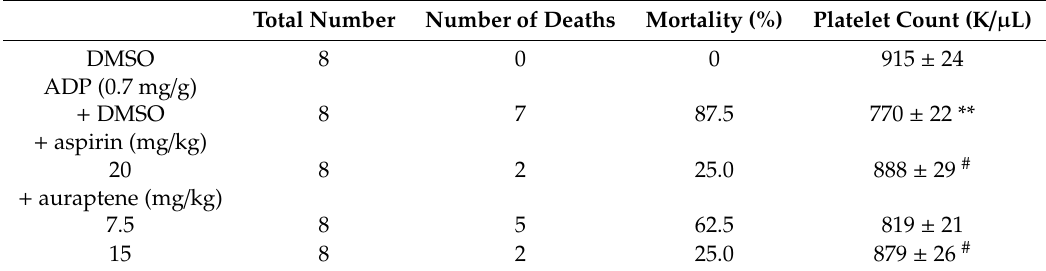
Table 1. E ff ect of aspirin and auraptene on mortality and platelet count of acute pulmonary thrombosis caused by intravenous injection of adenosine diphosphate (ADP) in experimental mice. Total Number Number of Deaths Mortality (%) Platelet Count (K / µ L) DMSO 8 0 0 915 ± 24 ADP (0.7 mg / g) + DMSO 8 7 87.5 770 ± 22 ** + aspirin (mg / kg) 20 8 2 25.0 888 ± 29 # + auraptene (mg /